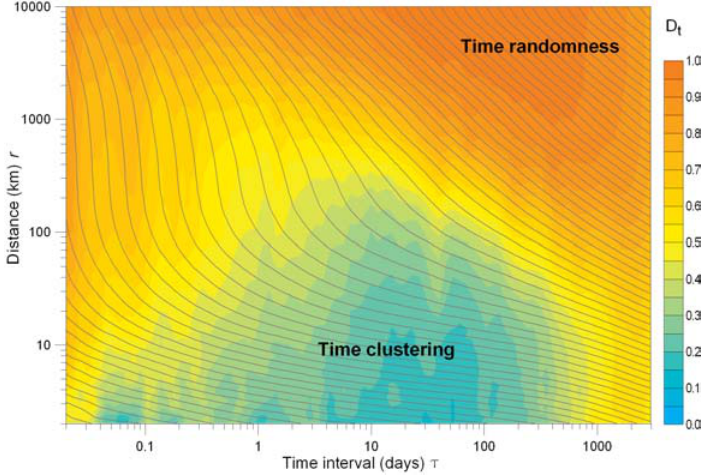
Fig. 1. Space-time combined correlation integral C c ( r , τ ) (dark contour lines) and time correlation dimension D t (coloured shaded contour) for the catalogue of global